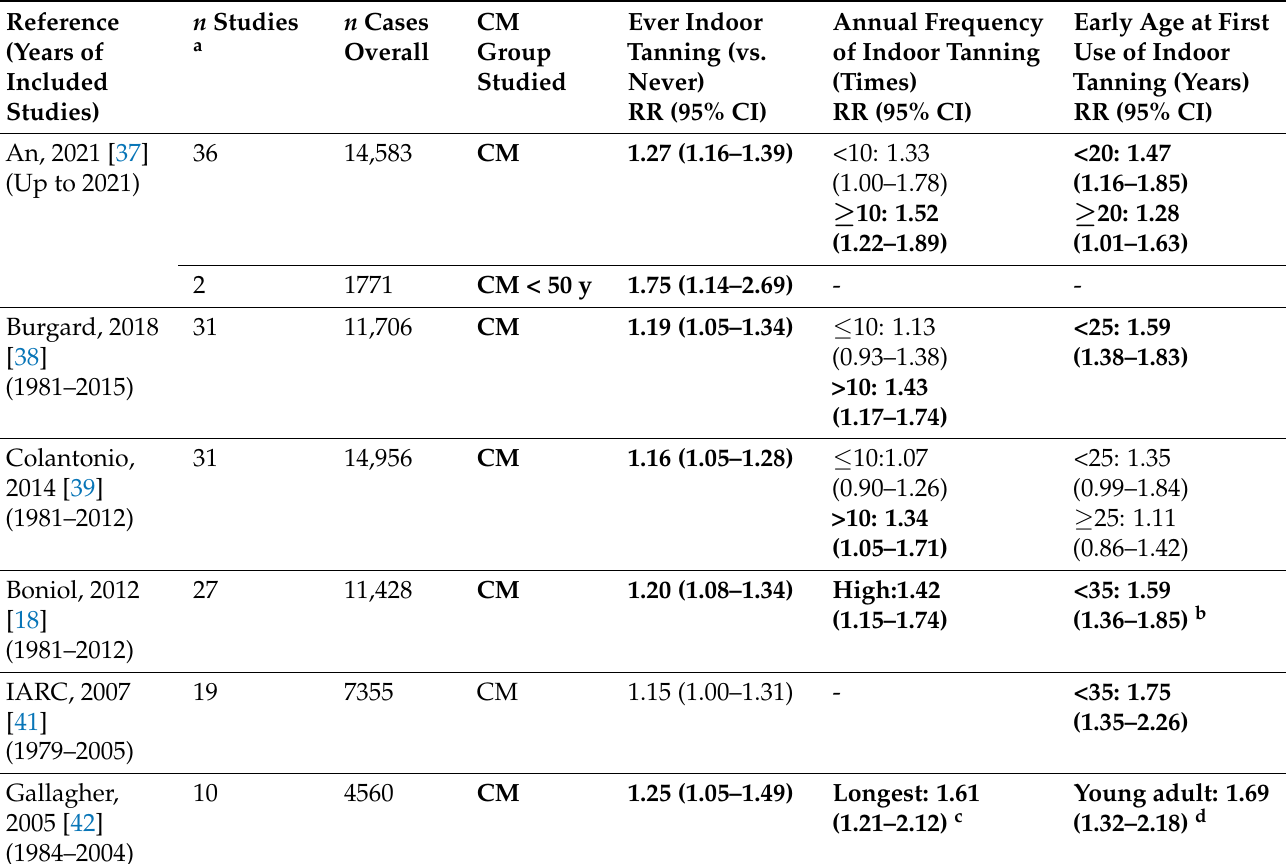
Table 2. Meta-analyses reporting indoor UVR tanning and risk of cutaneous melanoma. Available results by age group and dose/frequency of sunbed use are